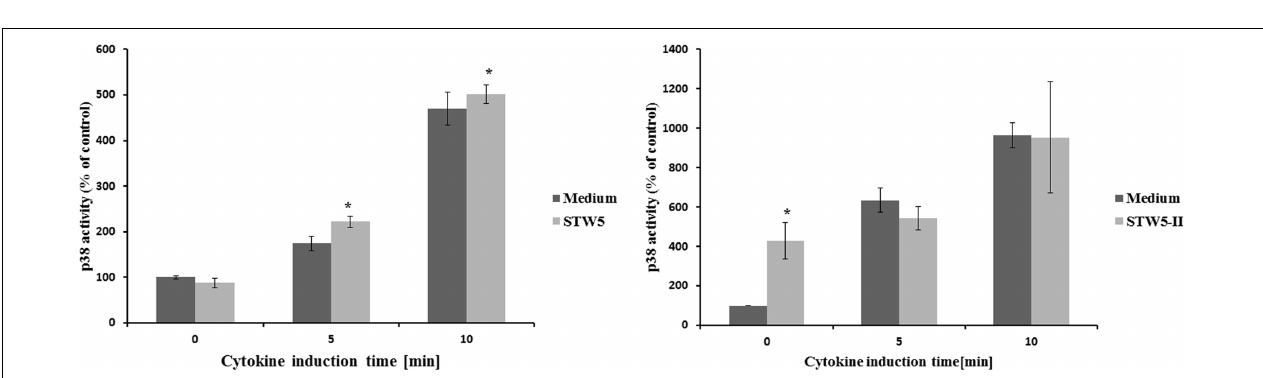
FIGURE 7 | Effects of single plant extracts on p38 activity: NCM460 cells were treated with STW5-II or STW5 at 20 µ l/ml for 1 h prior to induction with the CM (10 ng/ml TNF- α , 5 ng/ml IL-1 β , and 10 ng/ml IFN- γ ) for the indicated time points. Cell lysates were used to measure p38 activity by ATF-2 phosphorylation (pixel density fold change compared to 0 min medium treatment; three independent experiments; ∗ denotes statistical significance at p < 0.05 vs. medium treatment at the same induction